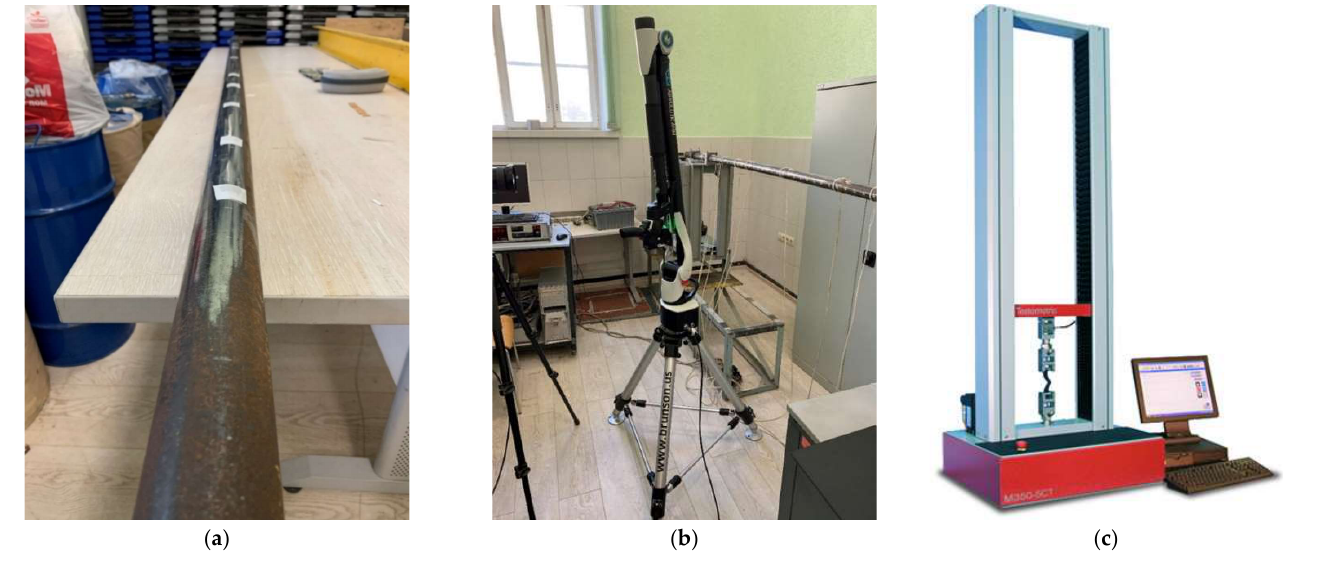
Figure 11. Laser scanner and electric press used during the experiment: ( a ) pipeline with a length of 2.4 m, an outer diameter of 51 mm and a wall thickness of 3 mm; ( b ) Hexagon RS6 Laser Scanner; ( c ) electric press Testometric M350-5CT.